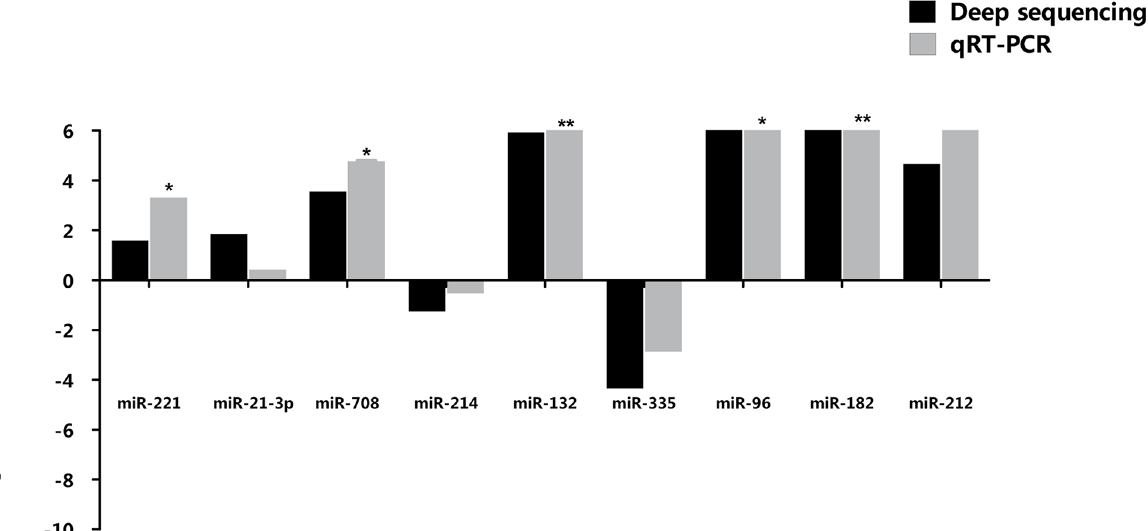
Fig 5. QPCR validation of selected candidate miRNAs differentially expressed between preovulatory dominant and subordinate follicles. The relative abundance of individual miRNAs is presented as the ratio of preovulatory dominant and subordinate follicles. The mean expression value of target miRNA was normalized against the expression of endogenous control U6 snRNA and 5s rRNAs. The normalized miRNA expression (2 - Δ CT ) in preovulatory dominant follicle was divided by the normalized miRNA expression in subordinate follicle and Log 2 transformed. MiRNAs with Log 2 ratio > 0 are up-regulated in preovulatory dominant follicles and miRNAs with Log 2 ratio < 0 are down-regulated in preovulatory dominant follicles compared to the subordinate follicles counterparts. Statistical significance of each miRNA are represented by asterisks; * , p < 0.05 and ** , p < 0.01.